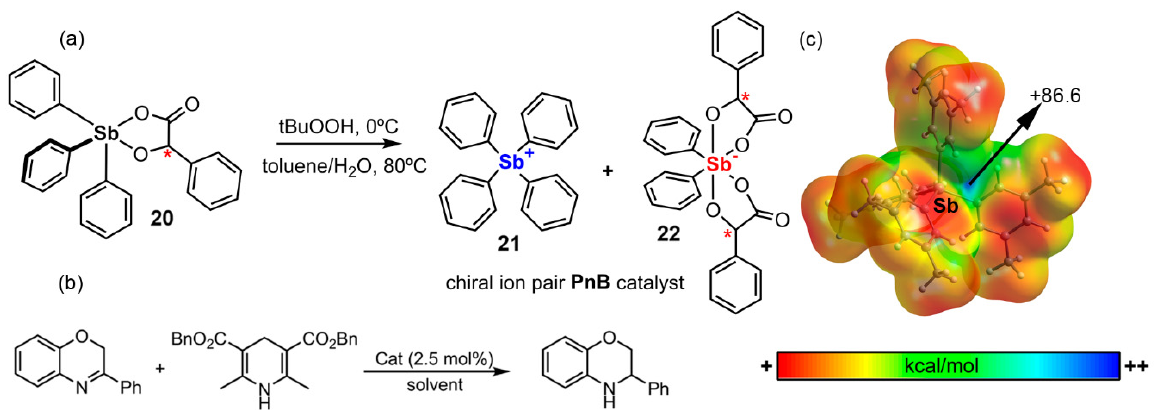
Figure 9. ( a ) Schematic representation of the synthetic procedure to obtain the chiral ion pair PnB catalyst (the methyl groups bound to the benzene rings have been omitted for sake of clarity), ( b ) reaction scheme of the benzoxanine reduction with Hantzch ester and ( c ) MEP surface of compound 21 (B3LYP/def2-TZVP). The energy value shown at the selected point in the surface is given in kcal/mol (0.001 a.u.). Chiral centers are denoted by a red * in the figure.